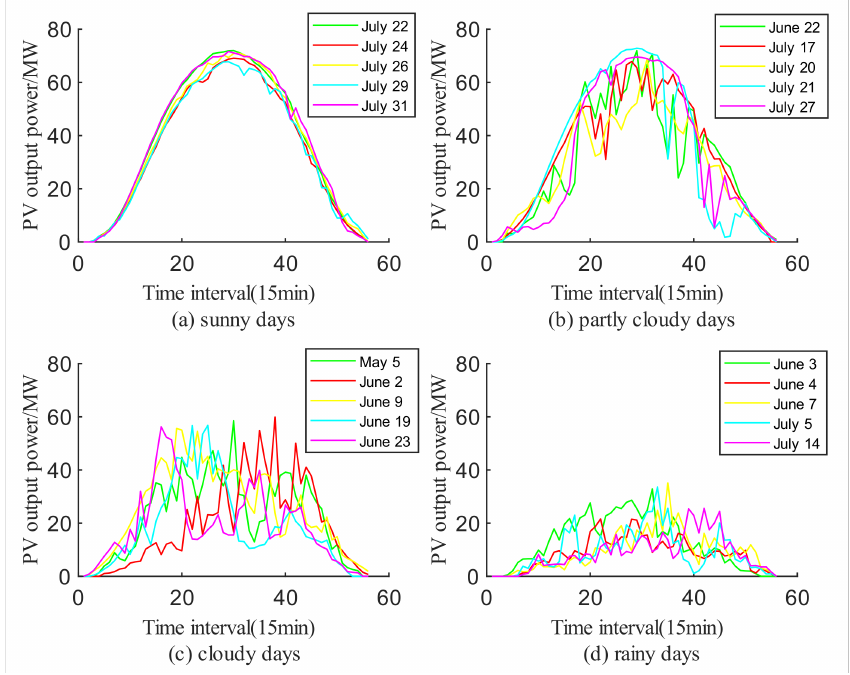
Figure 1. Typical weather-PV output power curves. ( a ) Typical weather for sunny days ( b ) Typical weather for partly cloudy days ( c ) Typical weather for cloudy days ( d ) Typical weather for rainy days. Table 1. Correlation coefficients for the first 7